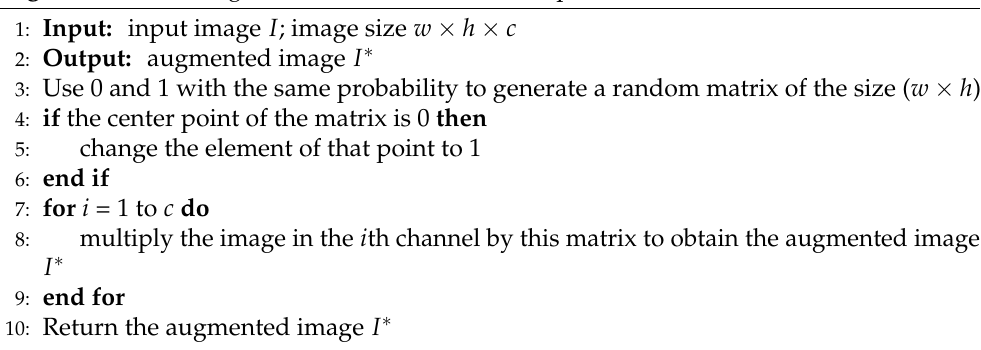
Algorithm 2 Selecting Discrete Points to Remove Spectral Information.